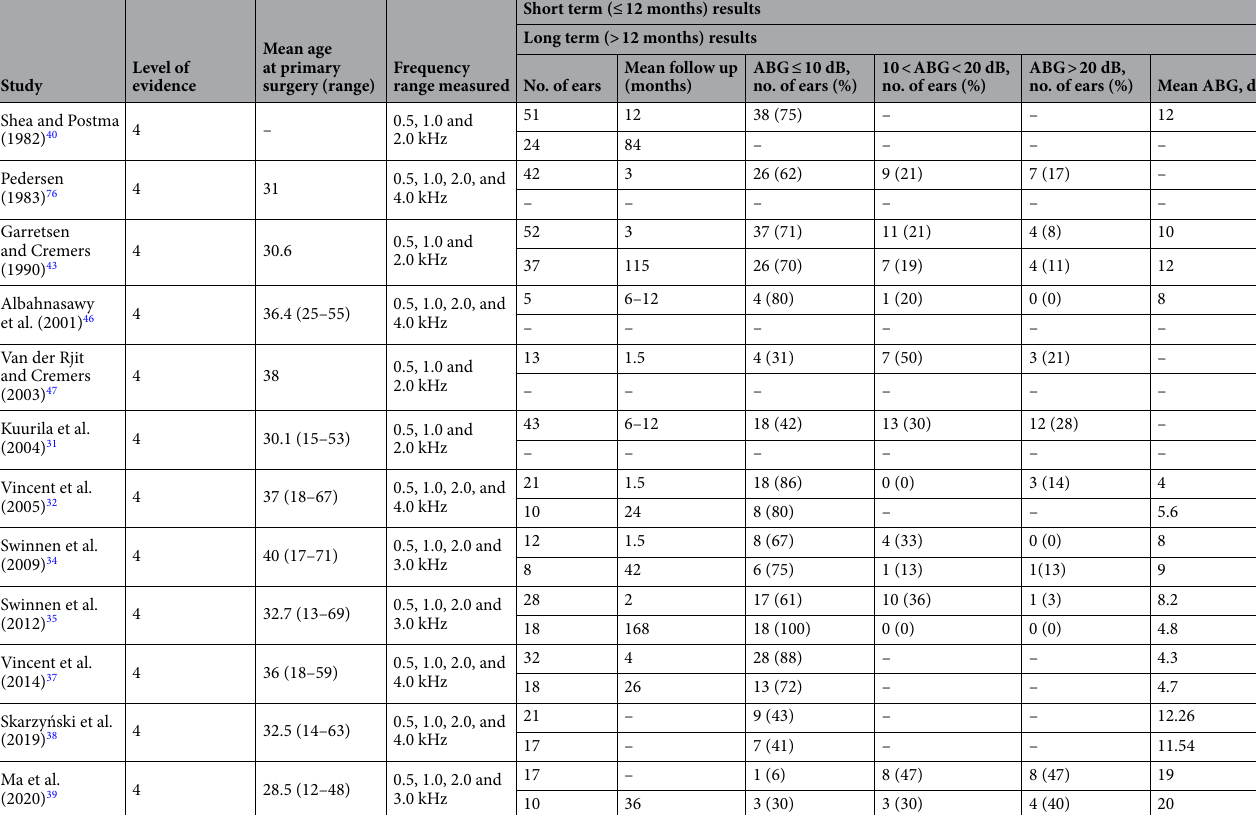
Table 2. Short-term and long-term audiometric postoperative results following stapes surgery in individuals with osteogenesis imperfecta. No sufficient data is indicated with a line (-). ABG is Air Bone Gap. Level of evidence 4 refers to well-designed case-series or cohort studies 58 .